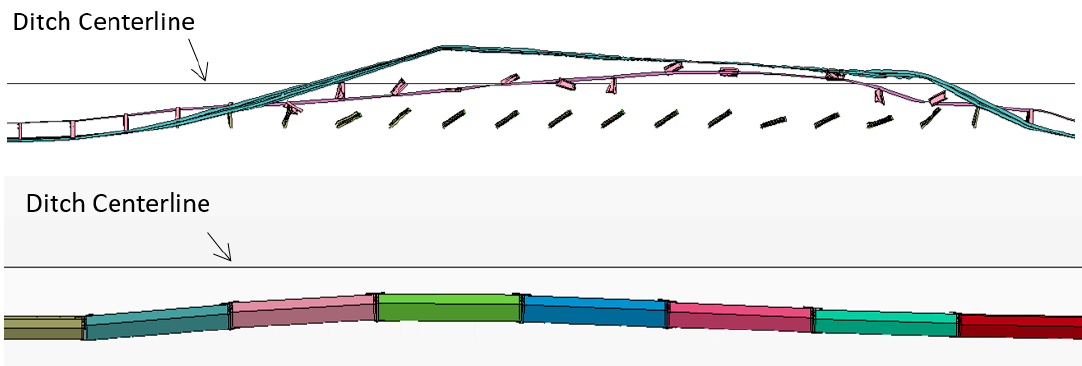
Figure 12. Damage comparison for steel EDSP-1.33 and concrete C470 barriers after the bus impact simulation (overhead view).